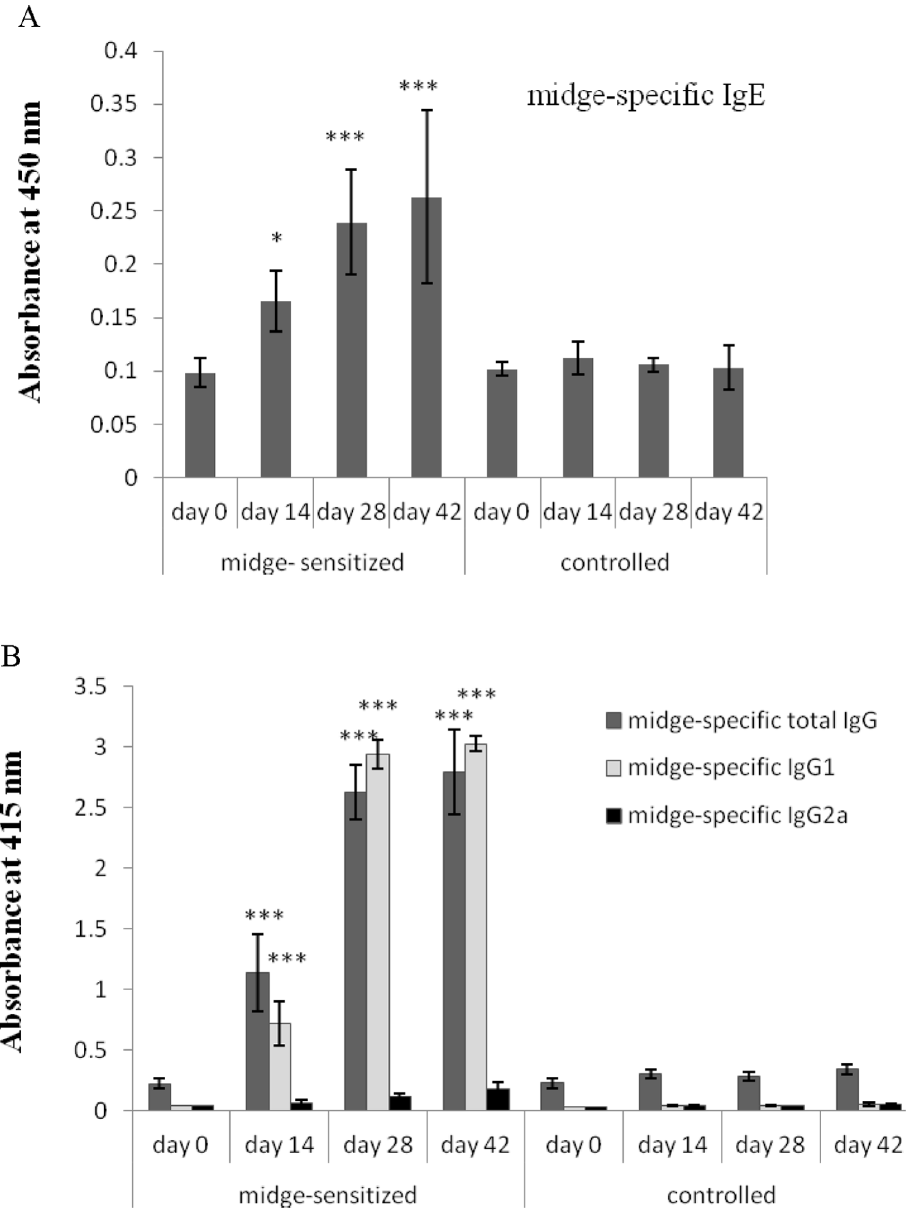
Figure 4. Specific antibody levels in midge-sensitized or controlled mice. (A) Midge-specific IgE and (B) total IgG, IgG1, and IgG2a antibodies in the sera at the indicated days. Results are means OD 6 SD (n=10 per group). * p , 0.05; *** p , 0.001, by one-way ANOVA with the Dunnett t test.